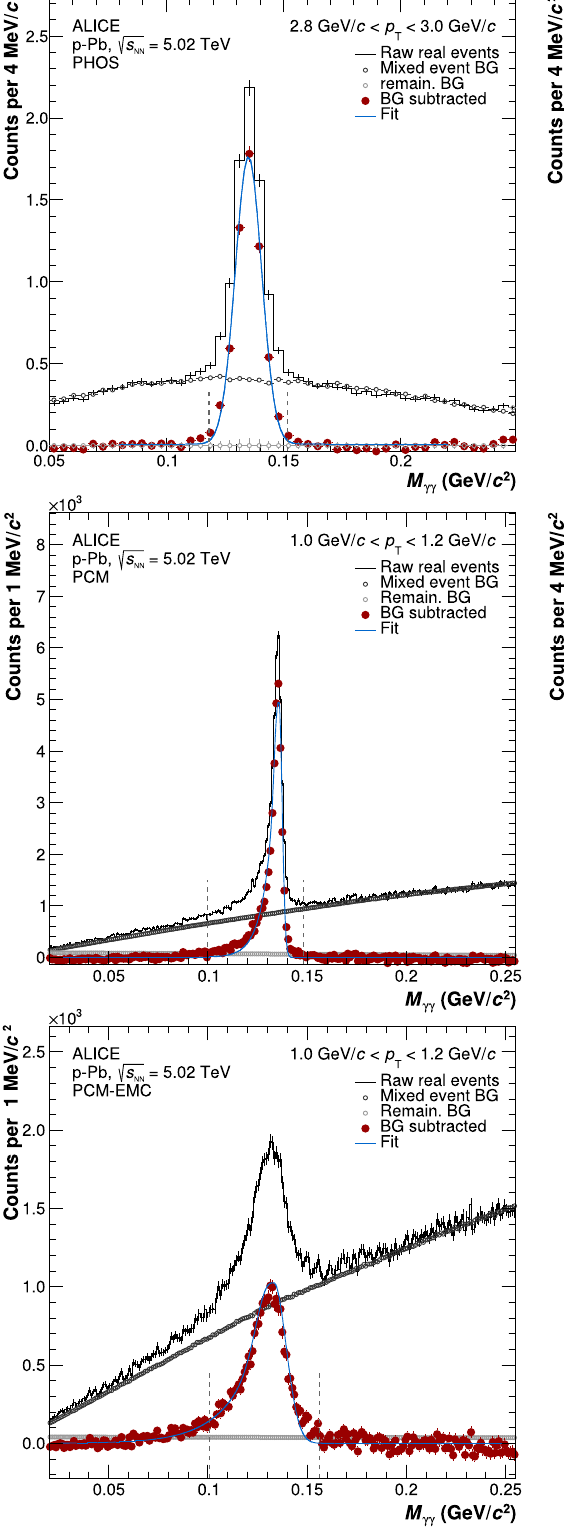
PCM-EMC. The vertical lines correspond to the limits of the region used to compute the integration of the meson